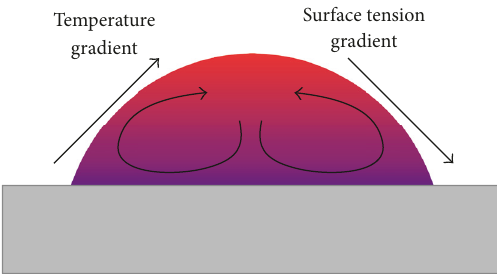
Figure6:ThermalMarangonieffectisproducedbyinhomogeneous cooling of the free surface due to evaporation. The temperature gradient in turn causes a surface tension